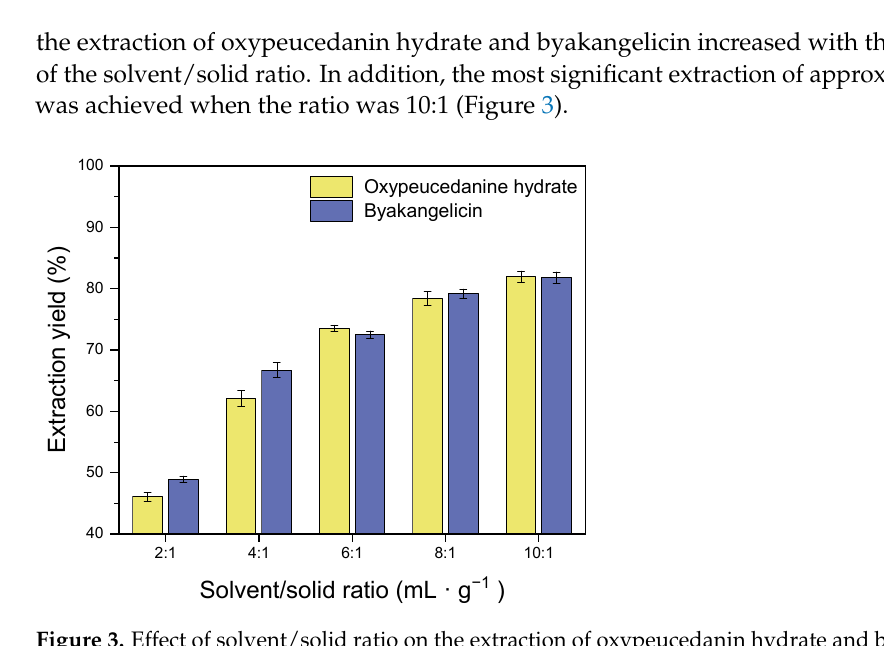
Figure 3. Effect of solvent/solid ratio on the extraction of oxypeucedanin hydrate and byakangelicin.